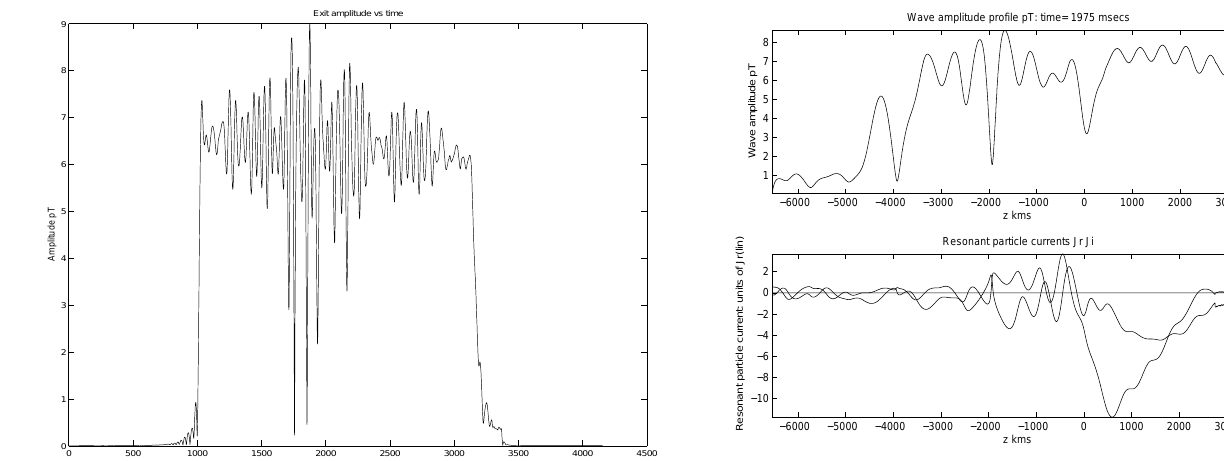
Fig. 5. Wave amplitude profile at the exit of the simulation box for the weak termination faller of Fig. 4. The strong oscillations correspond to the lower sideband wave with a separation of ∼ 25Hz.